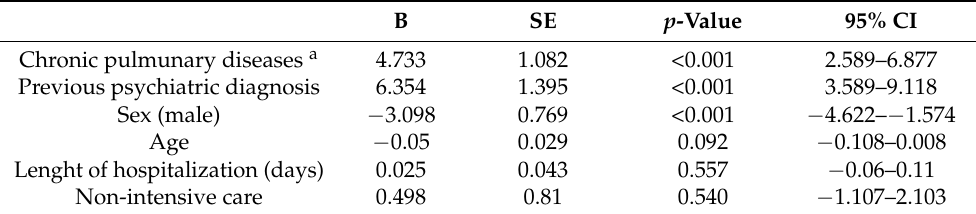
Table 2. Linear regression model predicting PHQ-9 total score.